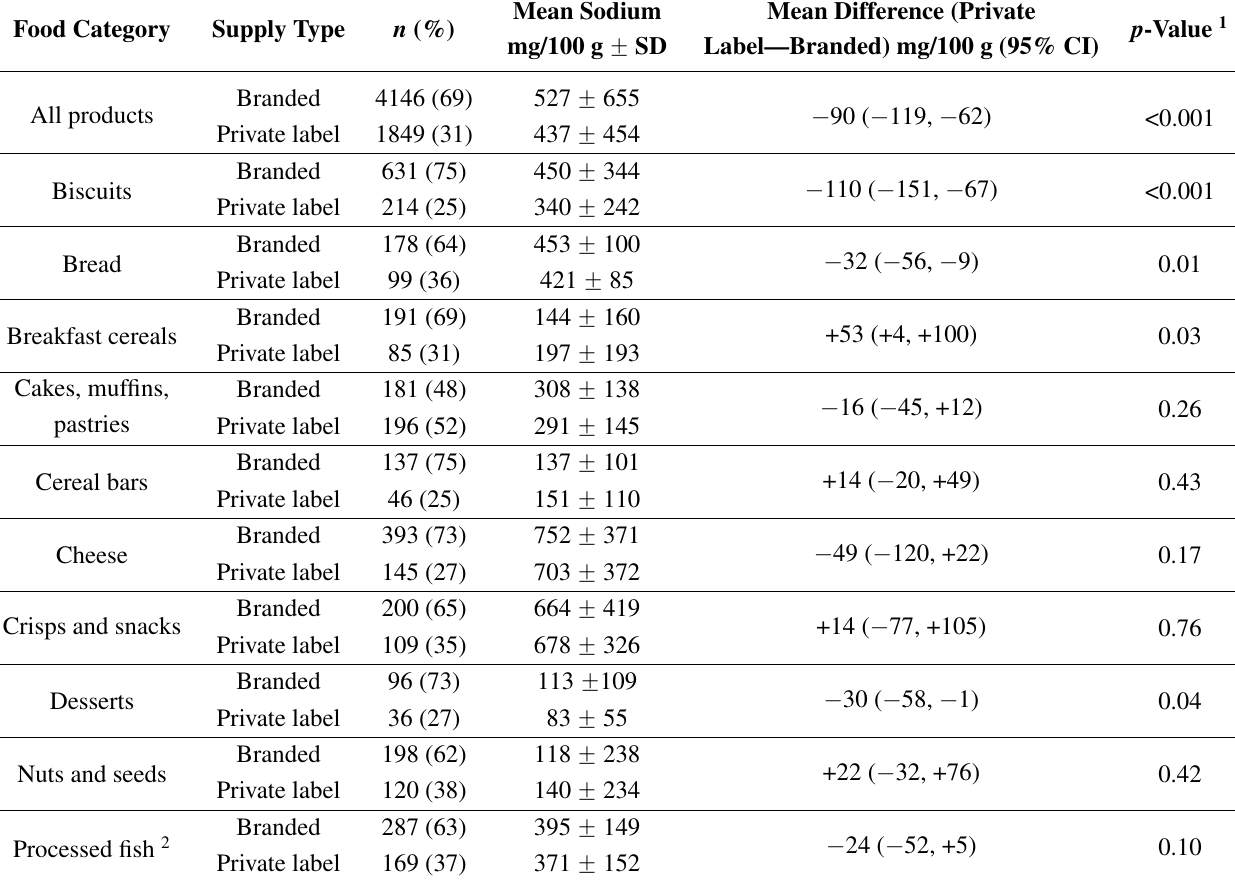
Table 1. Mean sodium levels (mg/100 g) in all supermarket private label and branded products on the supermarket shelves in 2013 and the differences between them, overall and for 15 major food